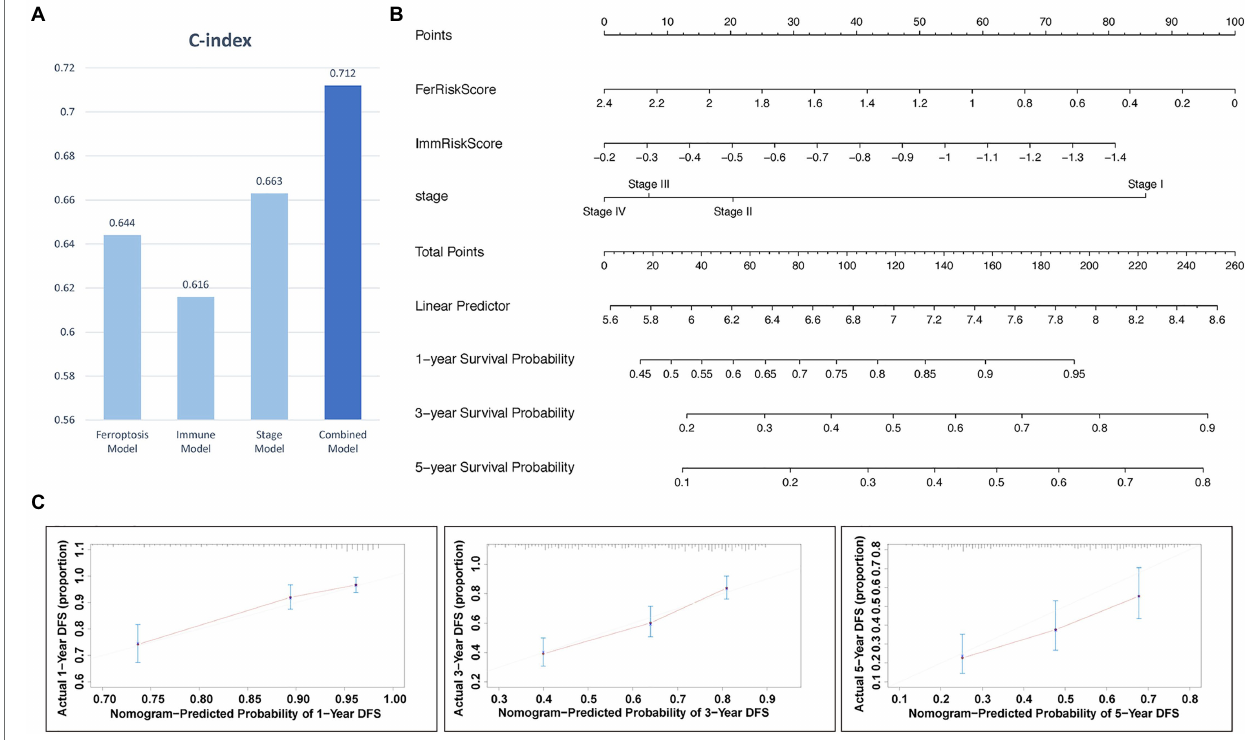
FIGURE 6 | The nomogram for predicting the 1-, 3-, and 5-year survival probability of patients with LUAD. (A) Comparison of C index among models. (B) Prognostic nomogram for predicting 1-, 3-, and 5-years OS probability of LUAD. (C) Calibration curves of the nomogram for assessing predicted OS at 1-, 3-, and 5- years in the TCGA